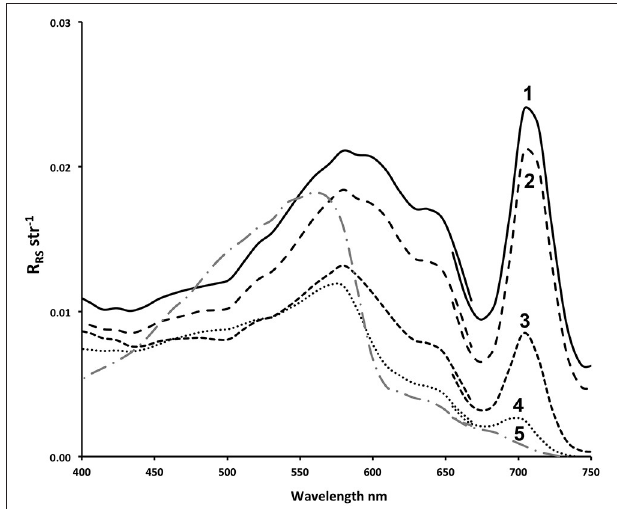
FIGURE 12 | Reflectance from selected shallow reef features in northern Kane’ohe Bay derived from AVIRIS imagery, collected on 3 March 2017; black curves, labeled 1 through 4 (see labeled areas in Figure 4B ), represent patch reefs colonized by coral and algae and the gray curve, labeled 5, represents an area that appears to be uncolonized